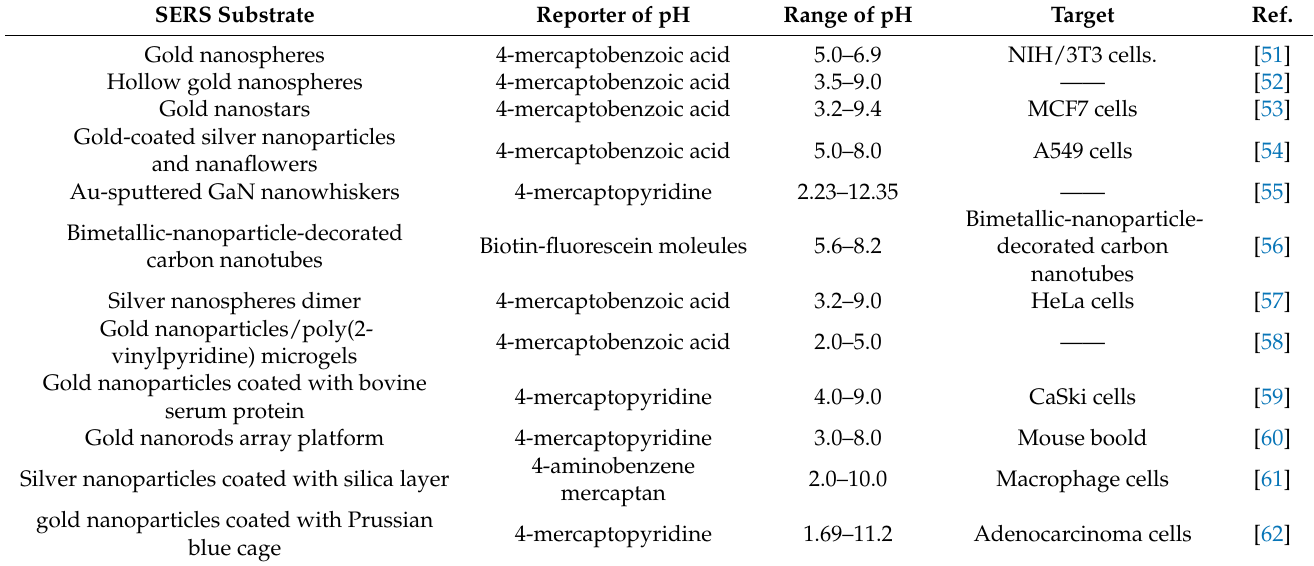
Table 1. Summary of some pH SERS